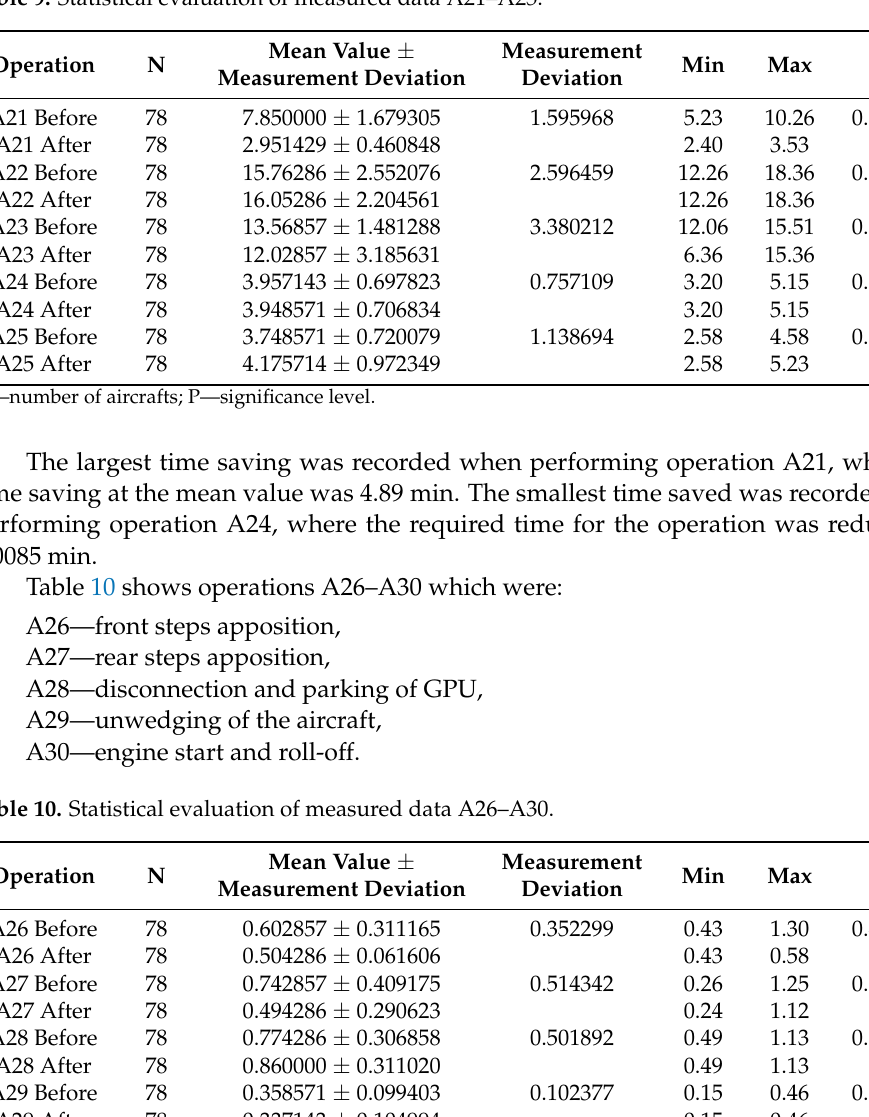
Table 9. Statistical evaluation of measured data A21–A25.